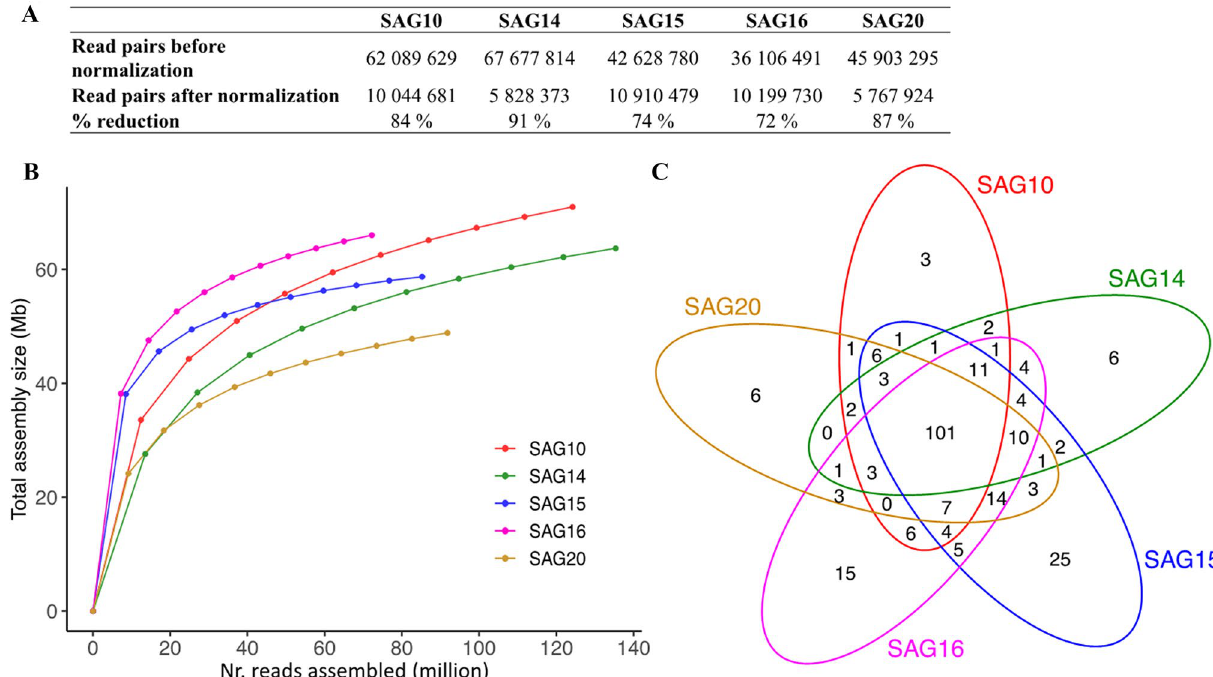
Figure 3. The effect of amplification bias on individual dMDA samples. ( A ) Number of paired Illumina reads before and after normalization with BBNorm. ( B ) Down-sampling analysis (of non-normalized reads) showing the assembly size (in megabases) on the y-axis and the number of paired reads used as input for the assembly on the x-axis. Plot created with the ggplot2 42 R package. ( C ) Venn diagram (drawn using the systemPipeR package 41 in R.) comparing the detected Chlorophyta BUSCO genes in each SAG